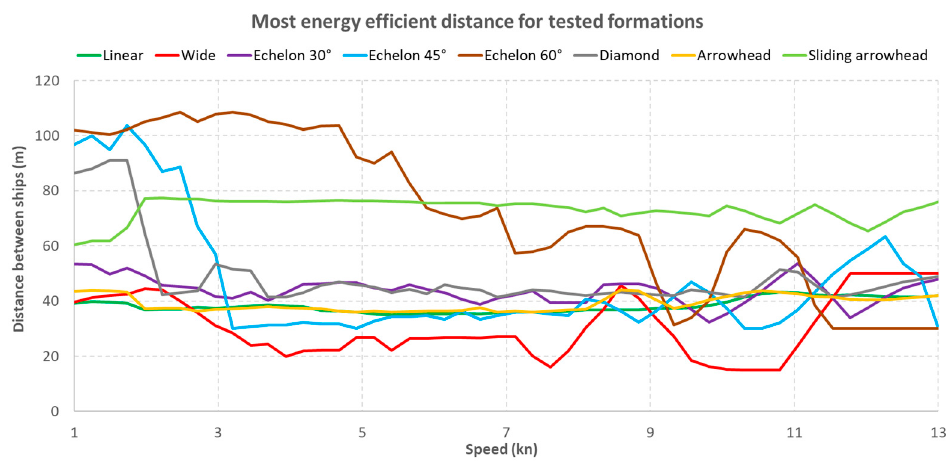
Figure 17. The distance that gives the least resistance for a given speed and shape of the formation.